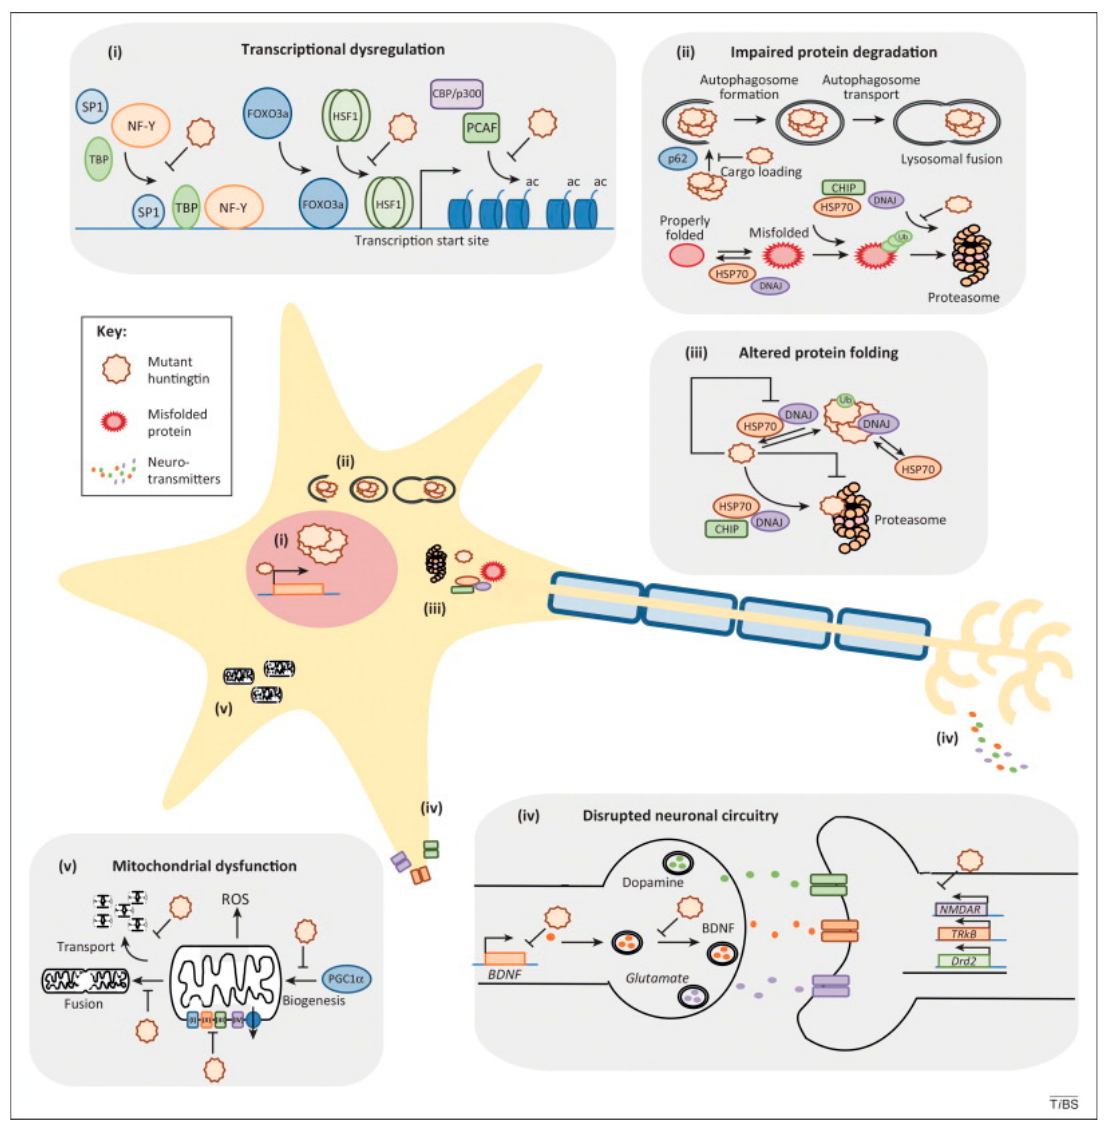
Figure 5. Schematic of significant cellular pathway disruptions causing Huntington’s illness (adapted with permission from [150] Elsevier, 2013).